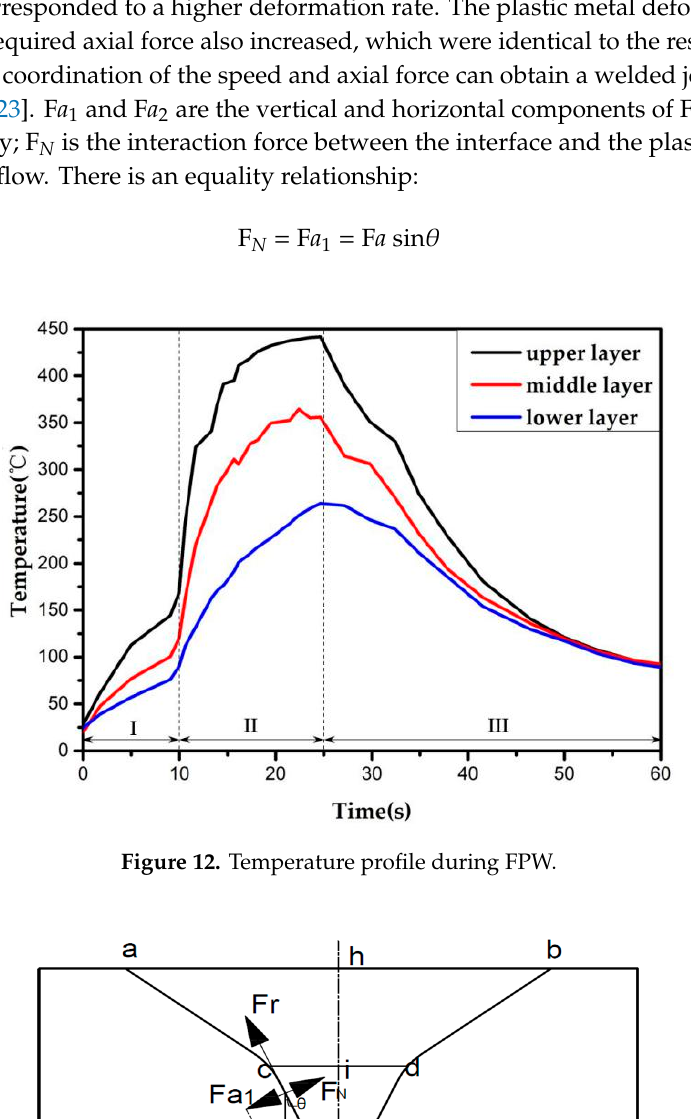
Figure 12. Temperature profile during FPW.